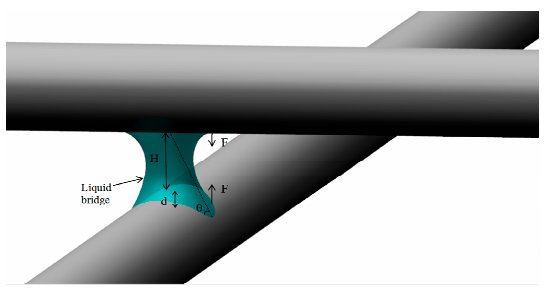
Figure 3. Schematic diagram of capillary force.